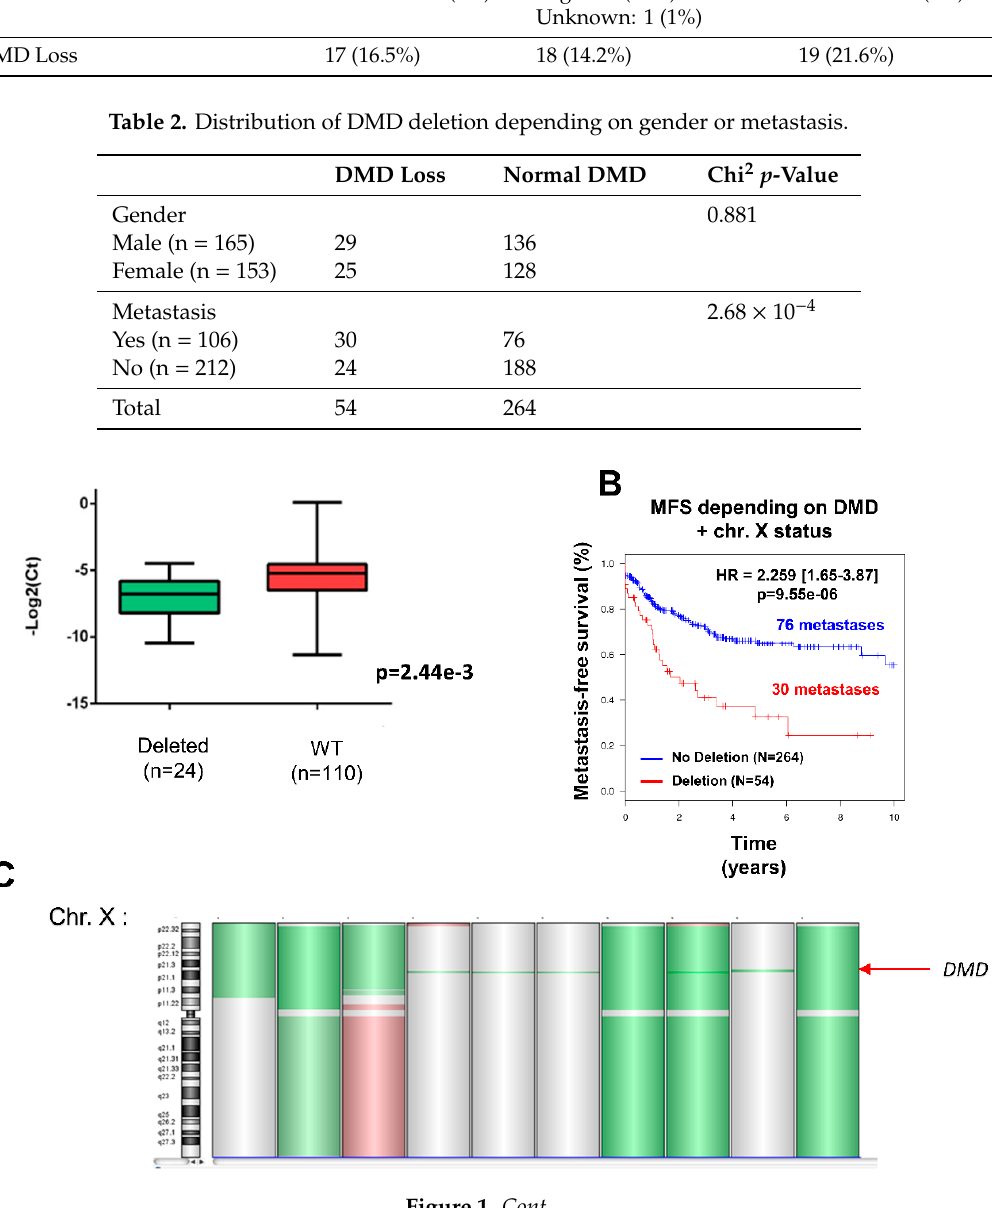
Figure 1. Deletion of DMD gene was significantly associated with metastatic evolution. ( A ) DMD expression determined by TaqMan comparing tumors with (in green) or without (in red) DMD deletion. ( B ) Kaplan–Meier analysis of metastasis-free survival (MFS) of sarcoma patients divided into two groups according to their DMD status (non-deleted in blue, DMD deleted in red). ( C )